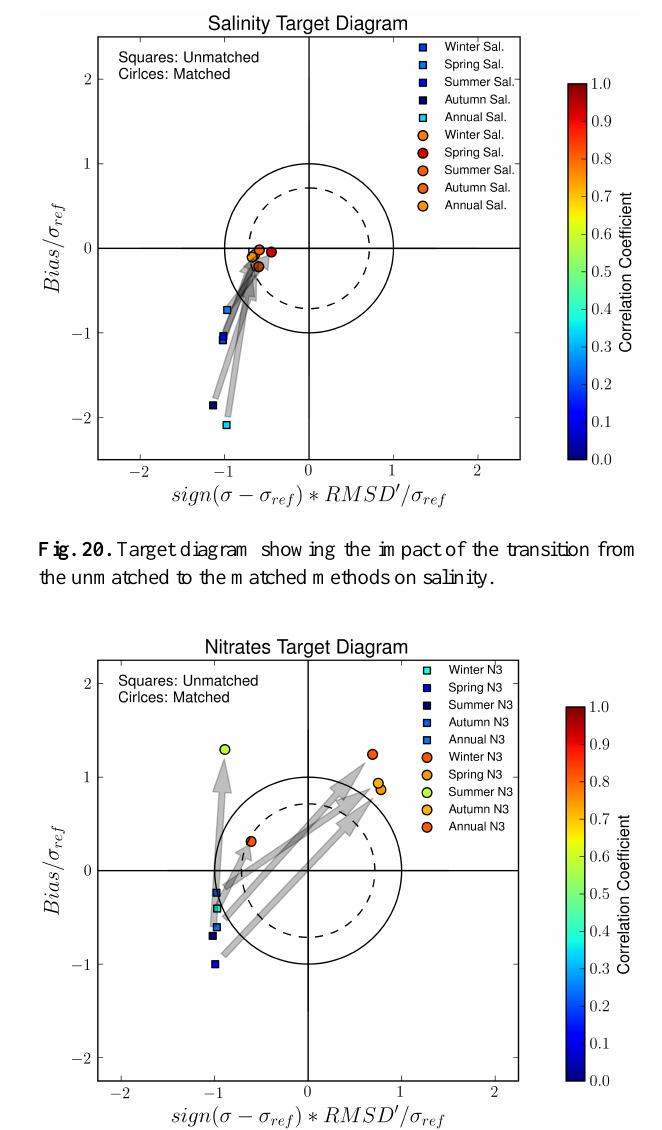
Fig. 21. Target diagram showing the impact of the transition from Fig.21. Targetdiagramshowingtheimpactofthetransitionfromtheunmatchedtothematchedmethods the unmatched to the matched methods on on nitrates.